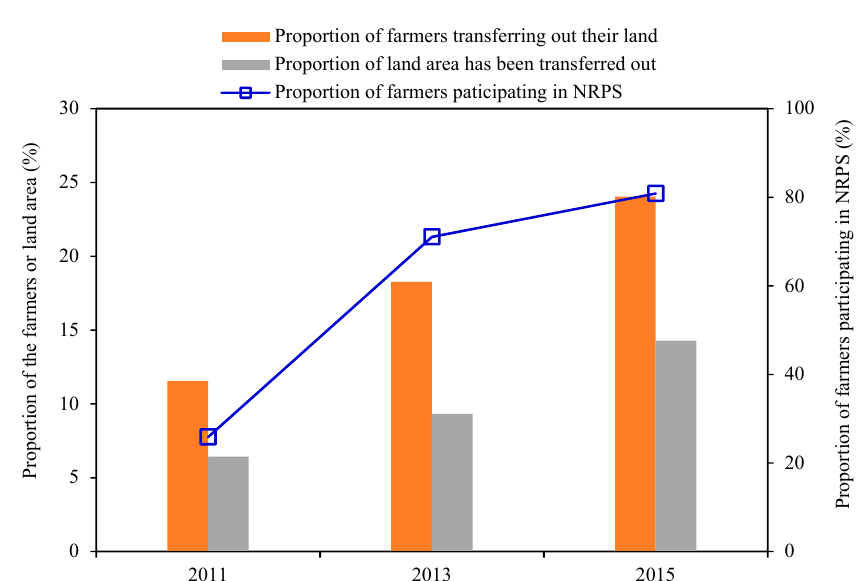
Figure 2. Proportion of farmers participating in NRPS and land transfer from 2011 to 2015.